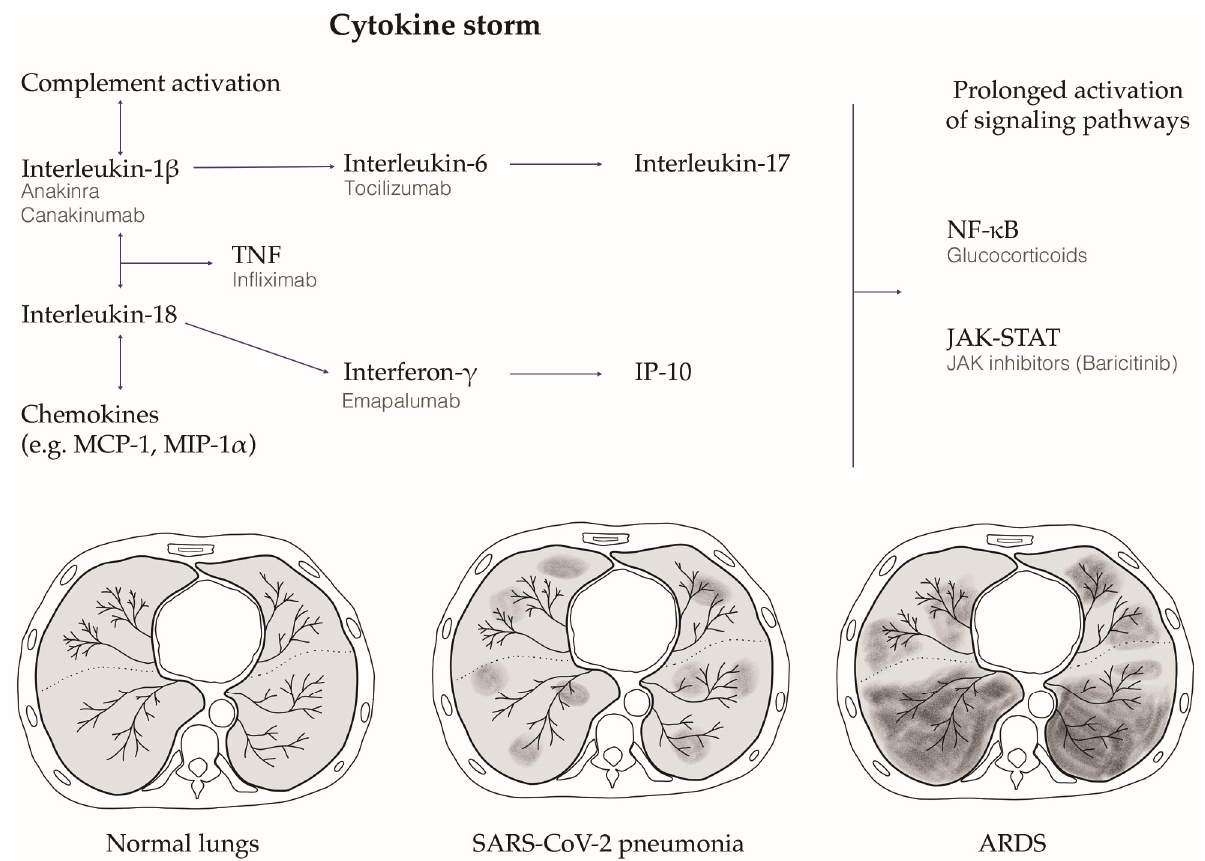
Figure 2. The SARS-CoV-2 infection induced cytokine storm and the relative lung damage. Af- ter SARS-CoV-2 infection, an innate and adaptive immune response is activated, which leads to the release of high amounts of pro-inflammatory cytokines (the cytokine storm schematically re- ported in the figure). This process clinically manifests first with respiratory failure and interstitial pneumonia, which are typically characterized by diffuse ground glass opacifications detected using high-resolution computed tomography. The more this process auto-amplifies, the higher is the risk for the patient to develop acute respiratory distress syndrome (ARDS) and multiorgan failure, which can finally lead to death. The figure schematically depicts axial slices from high-resolution computed tomography (HRCT) showing normal lungs, SARS-CoV-2 interstitial pneumonia with the typical ground glass opacifications, and the end-stage ARDS. Therapeutic strategies experimented in COVID- 19 targeting the cytokine storm pathways are also depicted. TNF, tumor necrosis factor; NF-kB, nuclear factor kappa B; JAK-STAT, Janus kinase—signal transducers and activators of transcription; Monocyte Chemoattractant Protein-1, MCP-1; Macrophage Inflammatory Protein-1 Alpha, MIP-1 alpha; Interferon gamma-induced protein 10, IP-10.